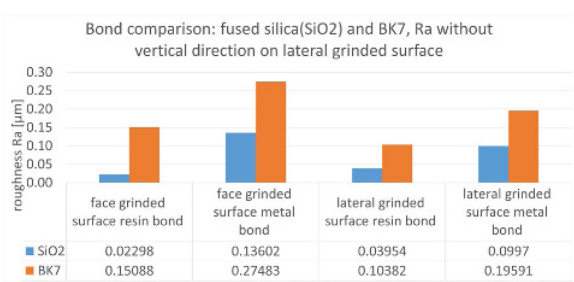
Fig. 3. Comparison: bond, mean value